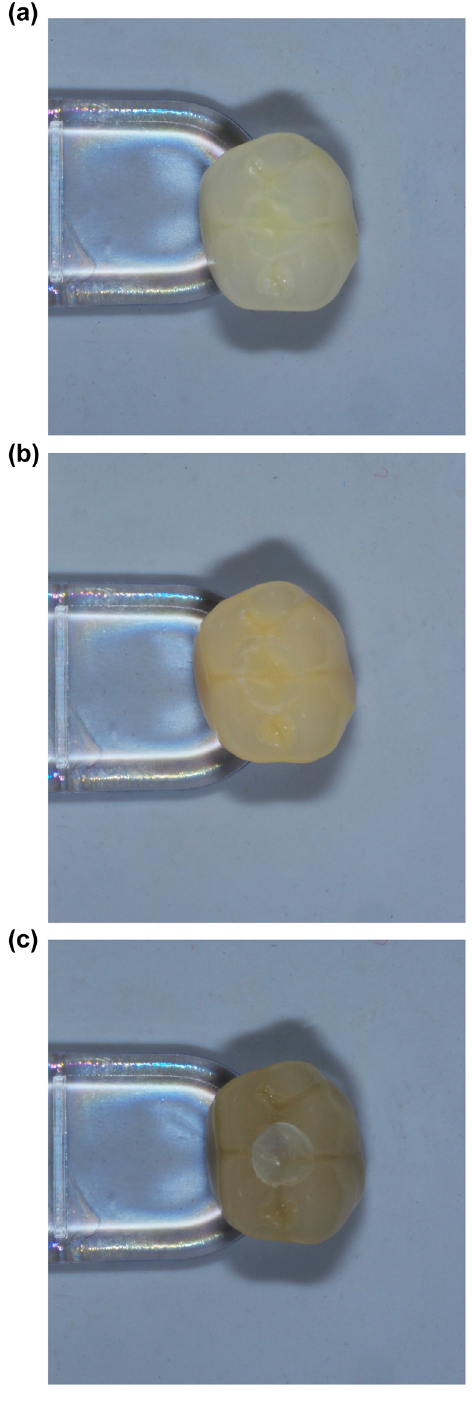
Figure 2: ( a – c ) Occlusal restorations in di ff erent shades of acrylic dentures, immediately after the polymerization ( a: B1 shade den - ture; b: A2 shade denture; c: C4 shade denture ) .